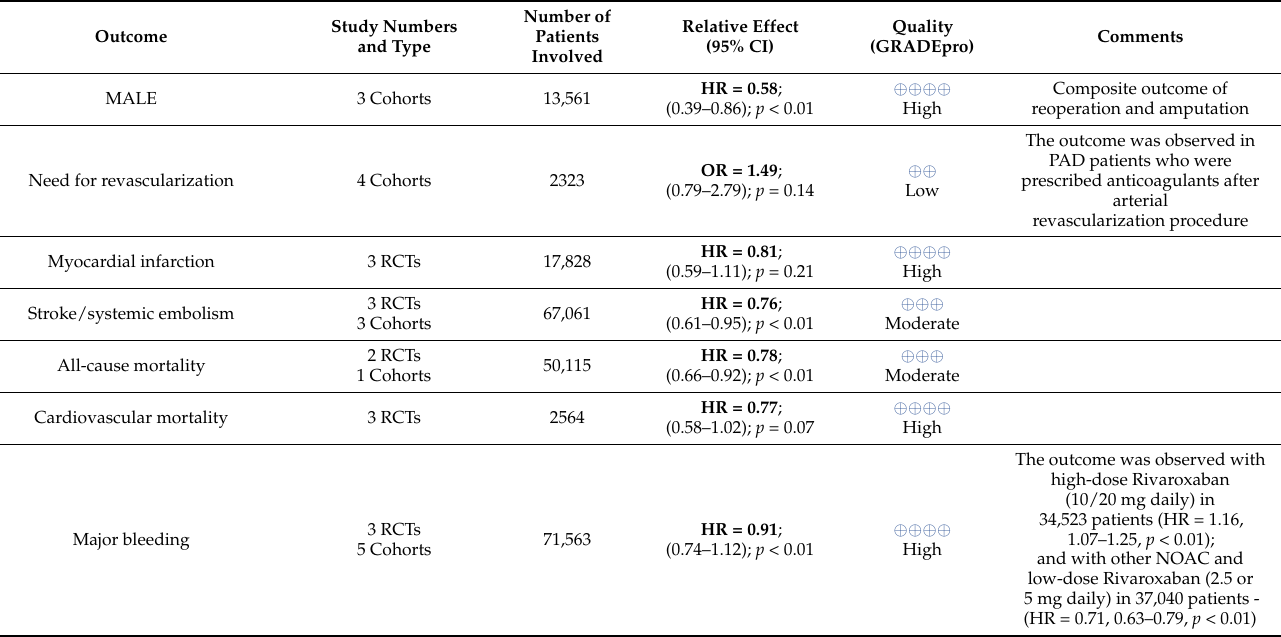
Table 3. Summary of findings table; CI—confidence interval, DOAC—direct-acting oral antico- agulant, HR—hazard ratio, OR—odds ratio, PAD—peripheral artery disease, RCT—randomized controlled